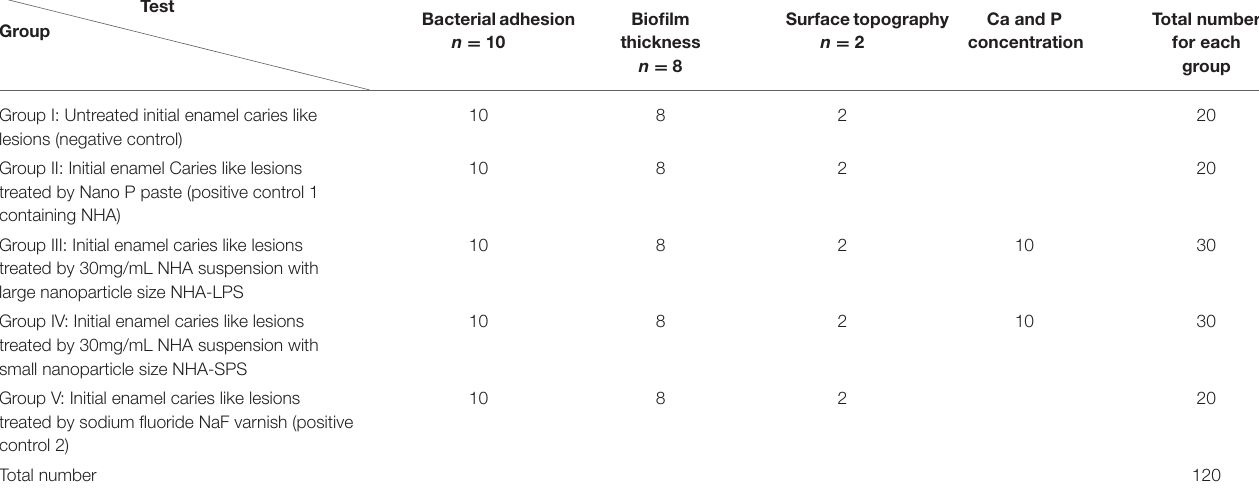
TABLE 1 | The experimental design of the study. Test Group